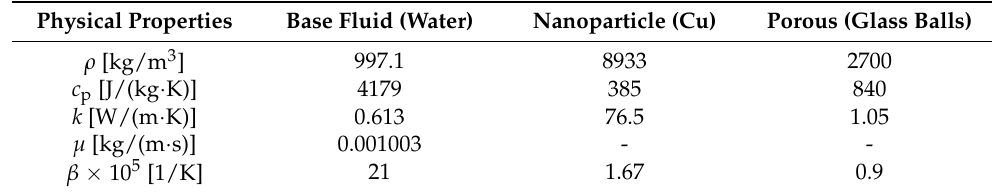
Table 1. Thermal physical properties of the base fluid (water), nanoparticle (Cu), and solid of the porous medium (glass balls).